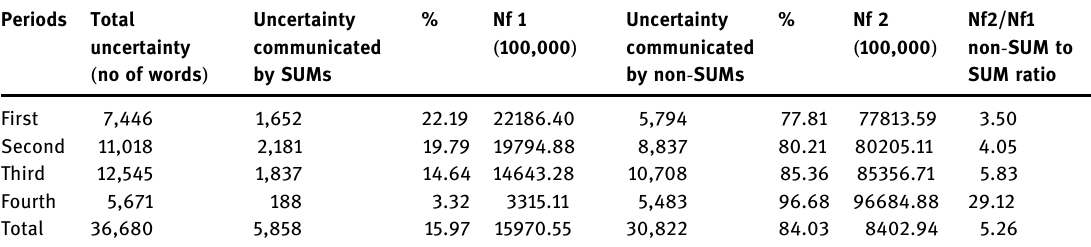
Table 15: Uncertainty communicated by SUMs and by non - SUMs both in the whole corpus and in each time period Periods